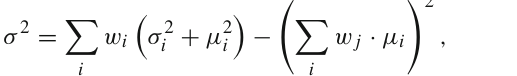
dle) and IC (right) detectors. Red lines show Gaussian shaped peaks for individual partitions, which have been rescaled by a factor of 20/5/1 for the BEGe/Coax/IC detectors for